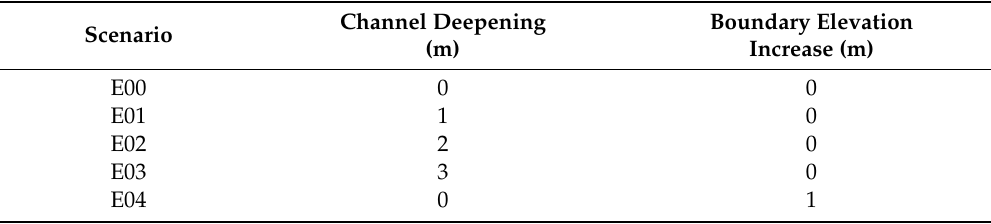
Table 1. Summary of numerical